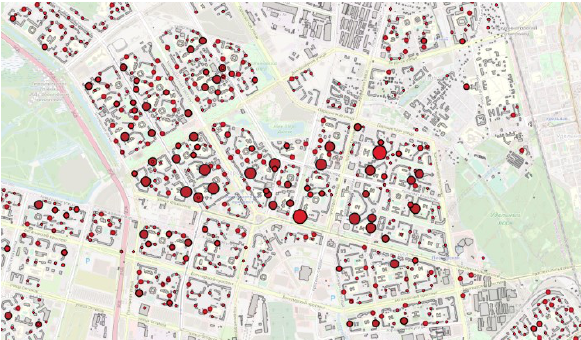
Figure 10. Visualization of HIV cases reported in 2006-2019 in Primorsky district of St. Petersburg; size of markers correspond with the amount of reported HIV cases (base map © OpenStreetMap